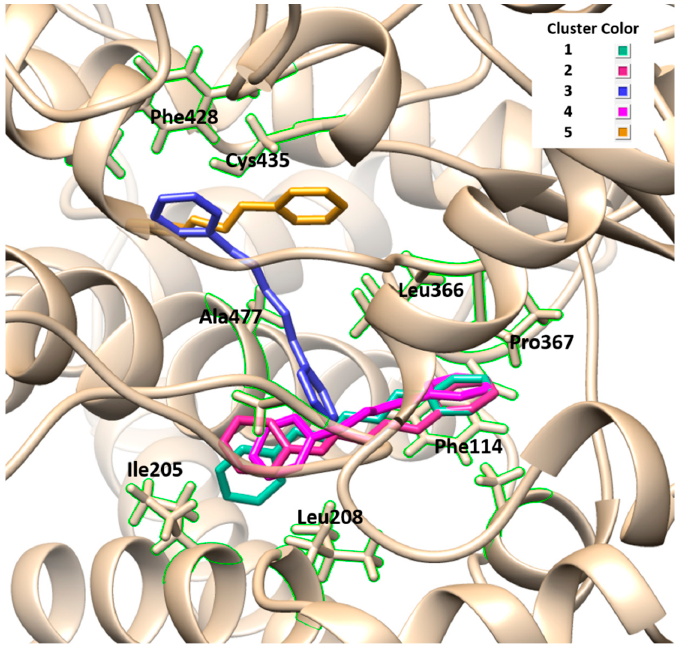
Figure 2. Solutions of the docking simulation of the CP-450 with CPH obtained with the SwissDock server.